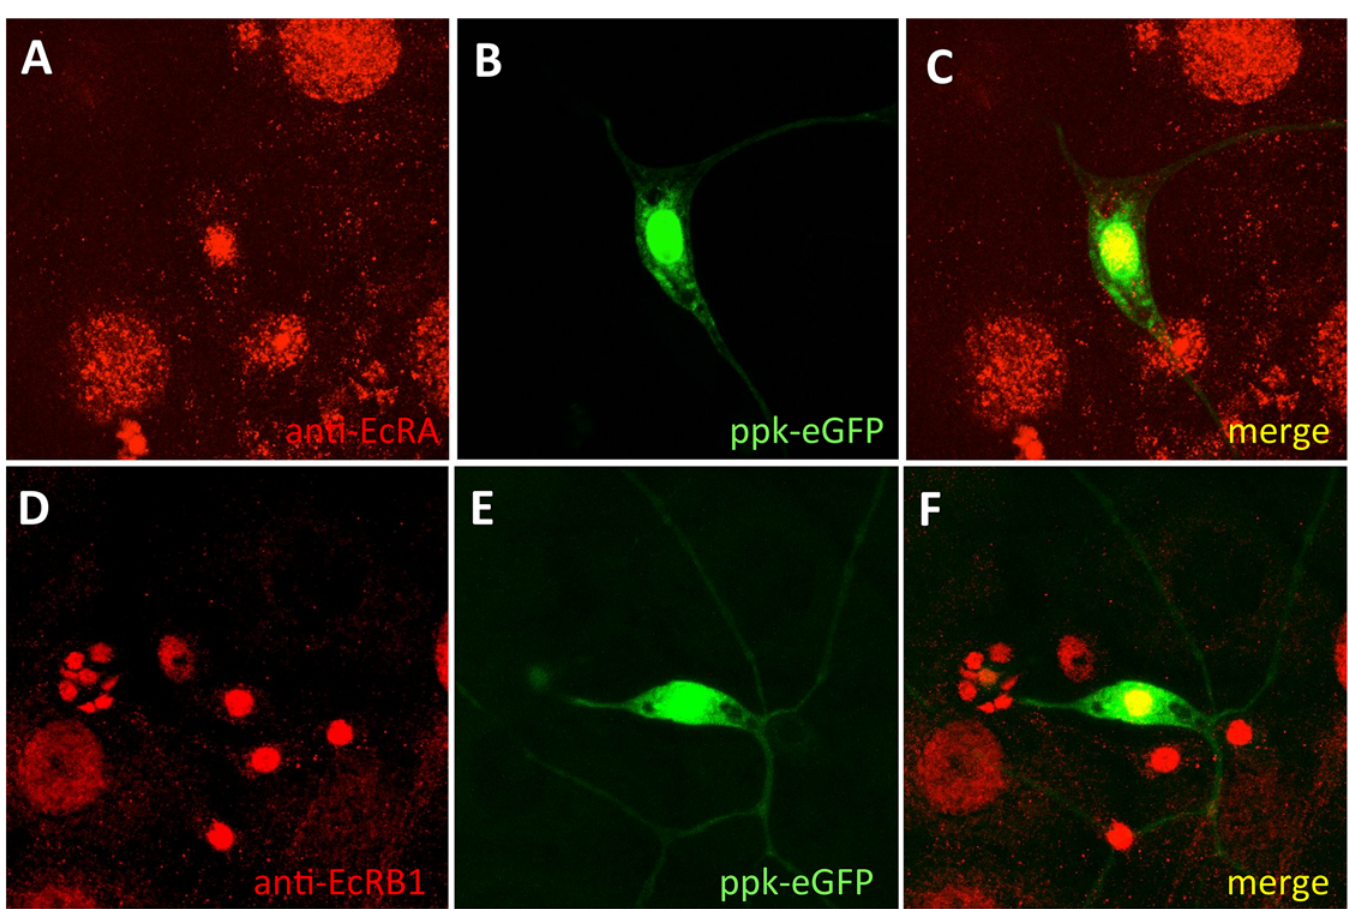
Fig 1. EcRA and EcRB1 are expressed in the class IV primary nociceptor neurons. (A) ppk-eGFP larva stained with anti-EcRA. (B) The class IV neuron is identified by eGFP expression in ppk-eGFP . (C) Merge of (A and B) indicates the presence of EcRA in the nociceptor neurons. (D) Sensory cluster of ppk- eGFP larva stained with anti-EcRB1. (E) Nociceptor neuron of same cluster is identified by eGFP expression in ppk-eGFP . (F) Merge of (D and E) indicates the presence of EcRB1 in the class IV nociceptor neurons.